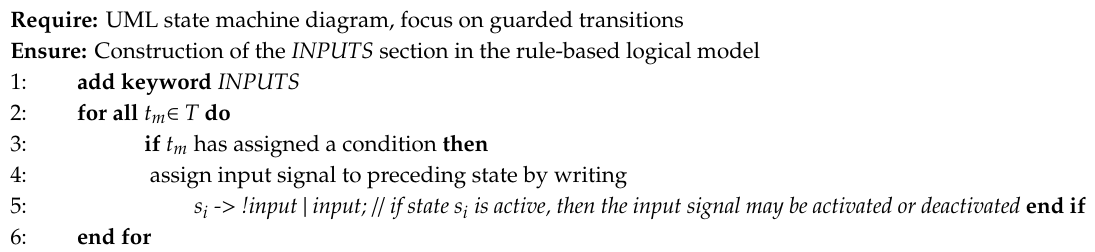
Algorithm 4. Generation of the INPUTS section in the rule-based logical model.